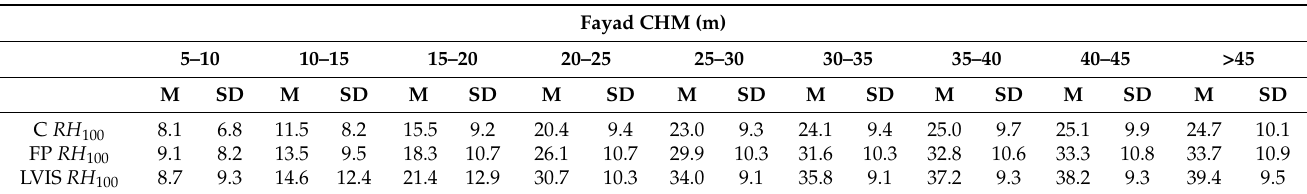
Table 1. Mean (M) and standard deviation (SD) in meters of the estimated RH 100 . (C) and (FP) correspond to the RH 100 values from GEDI’s coverage and full-power lasers, respectively. (LVIS) corresponds to the RH 100 values from LVIS.